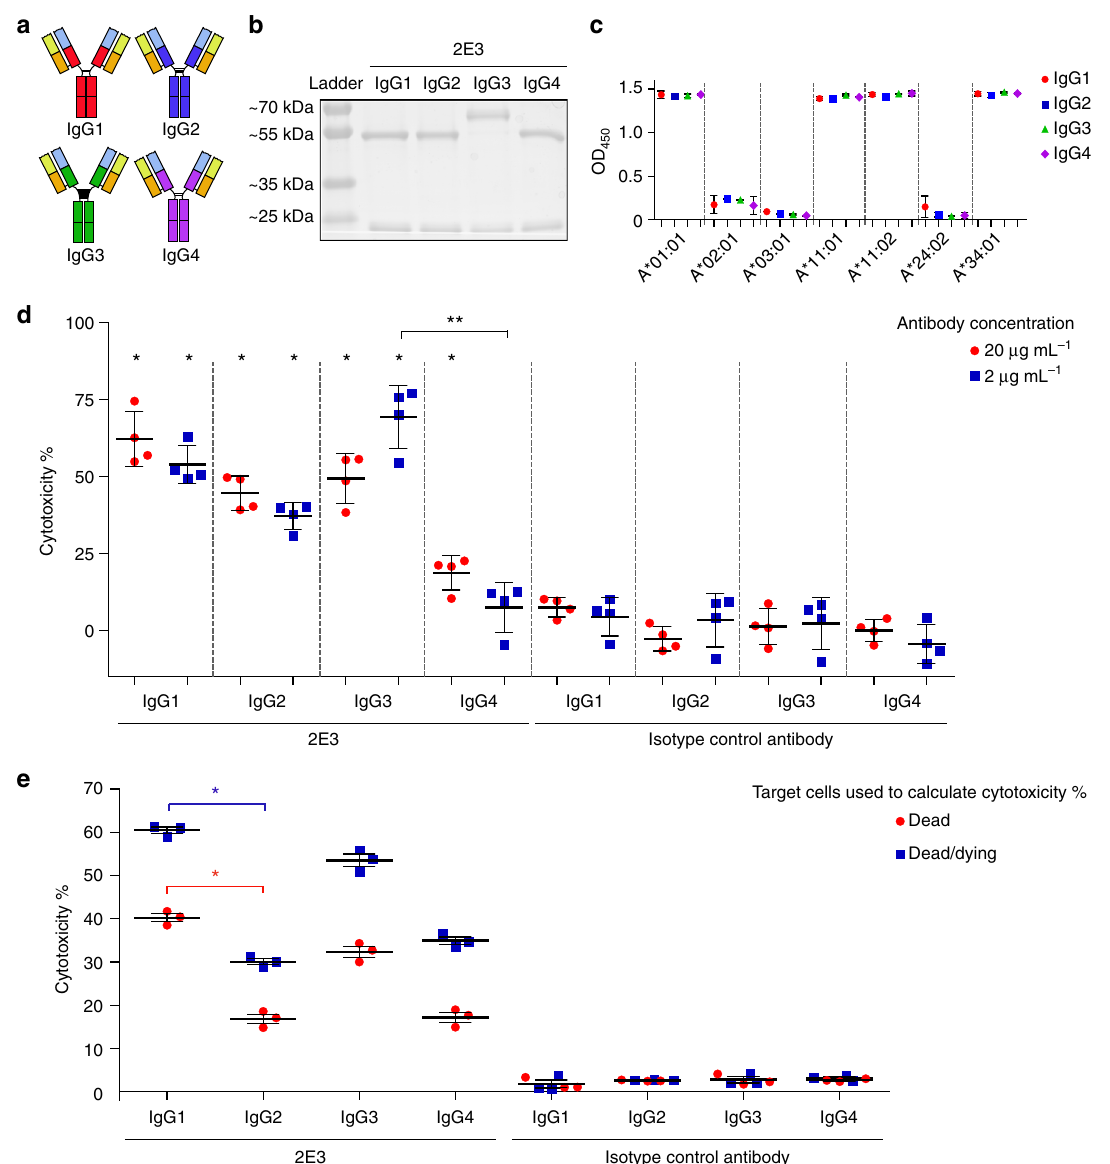
Fig. 4 The in fl uences of alloantibody IgG subclass on their effector function(s). a Schematic representation of the four human IgG subclasses. b Heavy and light chains of different subclasses of antibody 2E3 were resolved on polyacrylamide gel under reducing conditions. c Binding of four human IgG subclasses of alloantibody 2E3 at 1 μ g mL − 1 to refolded recombinant HLA monomers was tested by ELISA (mean ± s.d., N = 3 independent experiments). d CDC mediated by different IgG subclasses of 2E3 or respective isotype control antibodies (represented by target cell cytotoxicity) when incubated with complement (mean ± s.d., N = 4 independent experiments). * P = 0.0286, two-tailed Mann − Whitney test, compared with respective isotype control. **Gaussian approximated P = 0.0003 in Kruskal − Wallis test when compared all 2E3-treated groups, subsequently calculated to be statistically signi fi cant with P < 0.01 in Dunn ’ s multiple comparison test. e ADCC mediated by different IgG subclasses of 2E3 or respective isotype control antibodies (represented by target cell cytotoxicity) at a fi xed monoclonal antibody concentration (25 μ g mL -1 ) and effector:target ratio (4:1) when using NK cells as effector cells (mean ± s.e.m., N = 3 independent experiments). *Gaussian approximated P = 0.0156 when compared all 2E3-treated dead/dying cell populations, Gaussian approximated P = 0.0237 when compared all 2E3-treated dead cell population in Kruskal − Wallis test; subsequently calculated to be statistically signi fi cant with P < 0.05 in Dunn ’ s multiple comparison test. P = 0.1 (not signi fi cant), two-tailed Mann − Whitney test, when comparing each 2E3-treated group with the respective isotype control group. The source data underlying Fig. 4b – e are provided as a Source Data fi le. HLA human leukocyte antigens, ELISA enzyme-linked immunosorbent assay, CDC complement-dependent cytotoxicity, ADCC antibody-dependent cell-mediated carbenicillin and 25 μ g mL − 1 kanamycin at 30°C. On the following day, phage- were coated with HLA-A*11:01 at 4 μ gmL − 1 and blocked with 4% skim milk in containing supernatants were harvested and Fab phages precipitated using PEG. PBST buffer. Streptavidin was coated as a negative control. These plates were then An aliquot of the resulting PEG-precipitated Fab phages was used as the starting incubated with PEG-precipitated polyclonal Fab phages (diluted 10×) for 1 h. material for the following pan. Panning cycles were repeated four times to enrich Subsequently, the plates were incubated with anti-M13-HRP secondary antibodies for A*11:01-binding Fab phages. (GE Healthcare, cat. #27-9421-01, diluted 5000×) for 45min followed by TMB substrate for color development. Plates were washed four times in PBST buffer between all incubation steps. H 2 SO 4 was added to stop color development. The Polyclonal and monoclonal Fab phage ELISA . Single clones of Fab phages were polyclonal Fab phages that gave the highest OD 450 values for HLA-A*11:01 selected based on ELISA screening against HLA-A*11:01 28 . Brie fl y, maxisorp plates